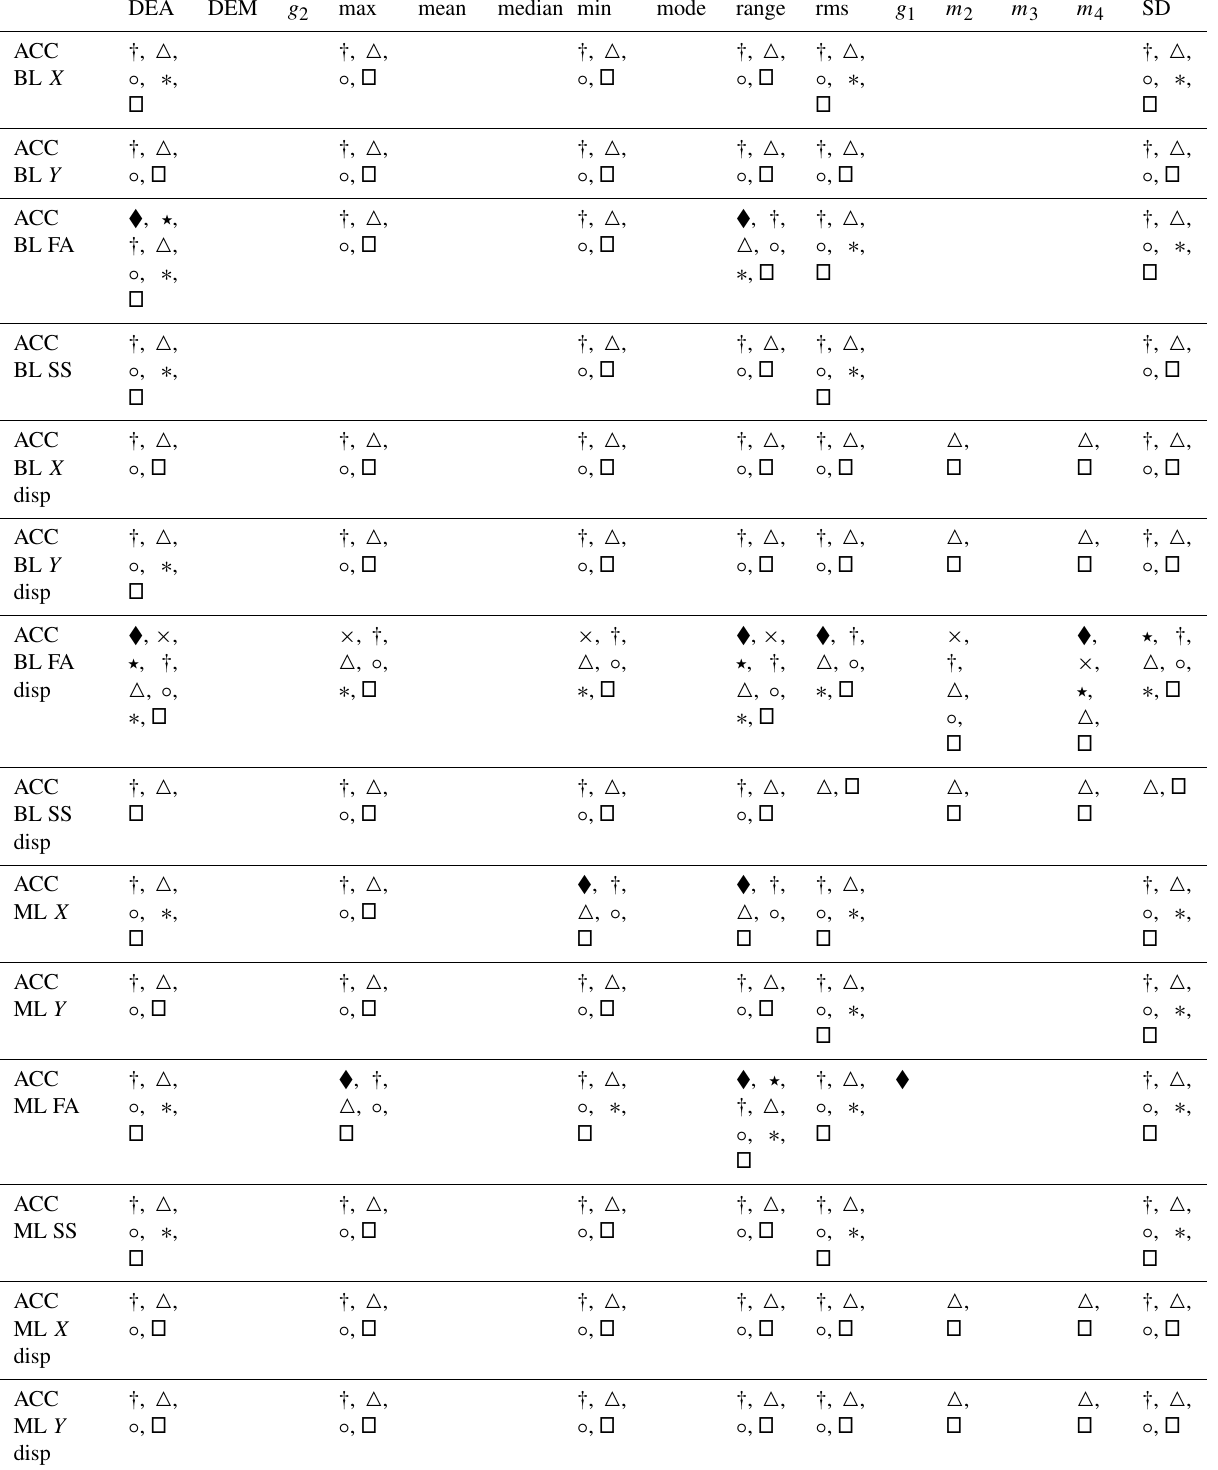
Table B2. Comparative table for different feature selection methods, wherein the differences between the selected parameters/metrics are illustrated. The rows in grey are SCADA-dependent parameters. Note the features ACC FA and ACC SS are the fore–aft and side-to-side accelerations captured by the nacelle’s low-quality